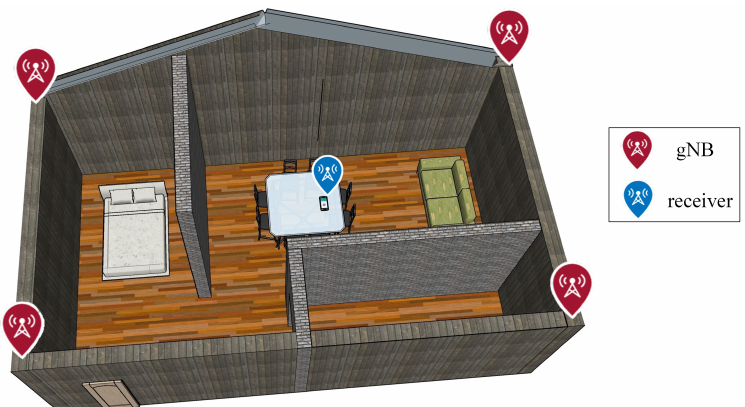
Figure 7. Schematic diagram of the 3D structure of the bedroom scene.